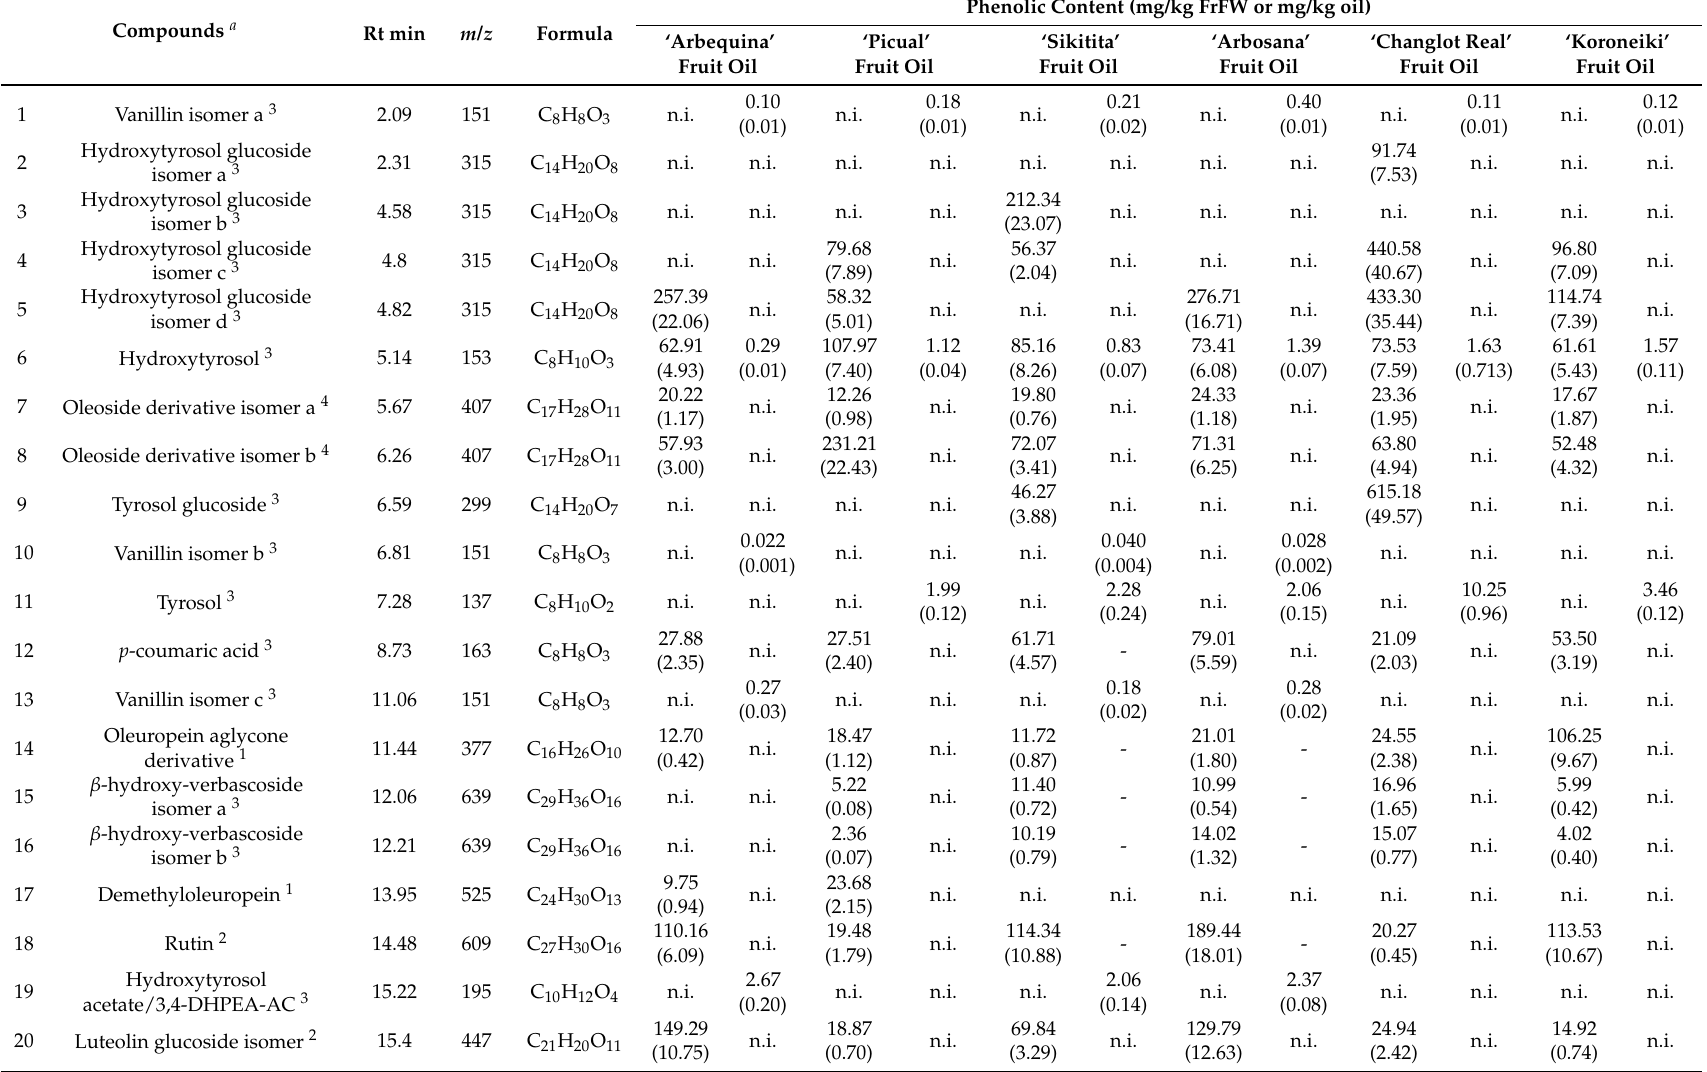
Table 1. Phenolic compounds determined in olive fruits and oils extract by HPLC-DAD-TOF-MS, including retention time, m/z , formula, means of compounds by cultivar, and total (mg/kg of fruit fresh weight (FrFW) or oil). Standard deviations (in parentheses); n.q. (not quantified); and n.i. (not identified). Compounds a Rt min m/z Formula